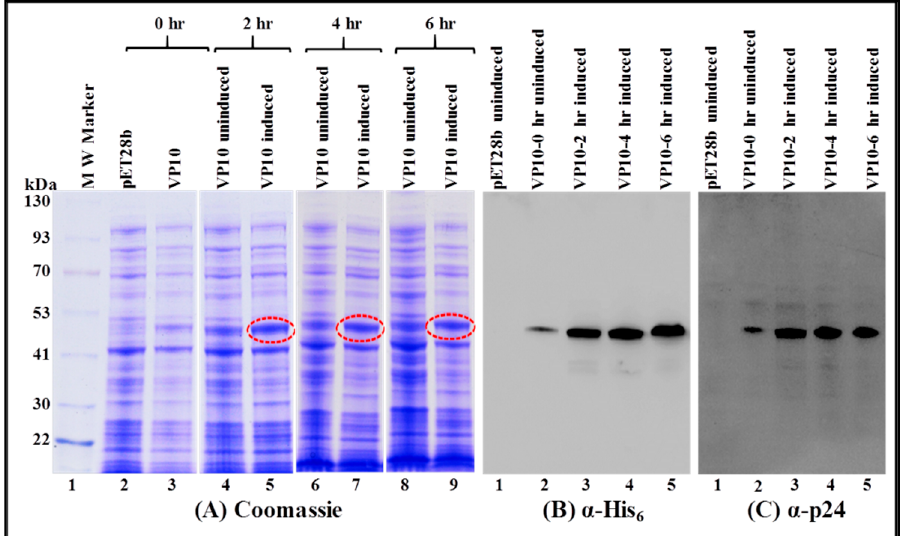
Figure 5. Expression of the recombinant FIV full-length Pr50 Gag -His 6 -tag fusion protein in a soluble fraction of Escherichia coli ( E. coli ). Bacterial cells transformed with VP10 were grown at 37 °C, then induced with IPTG and further cultured for varying time points at 37 °C. Soluble fractions prepared from uninduced and IPTG-induced cultures were electrophoresed on SDS-polyacrylamide gel. ( A ) Coomassie Brilliant Blue-stained gel confirmed that the full length Pr50 Gag -His 6 -tag fusion protein expressed efficiently from VP10 is present in the soluble fraction. Western blot analyses on the same soluble fractions from bacteria containing the Pr50 Gag -His 6 -tag fusion protein were conducted using α -His 6 ( B ) and α -FIV p24 ( C ) monoclonal antibodies, respectively, which further confirmed the presence of the fusion protein in the soluble fractions.